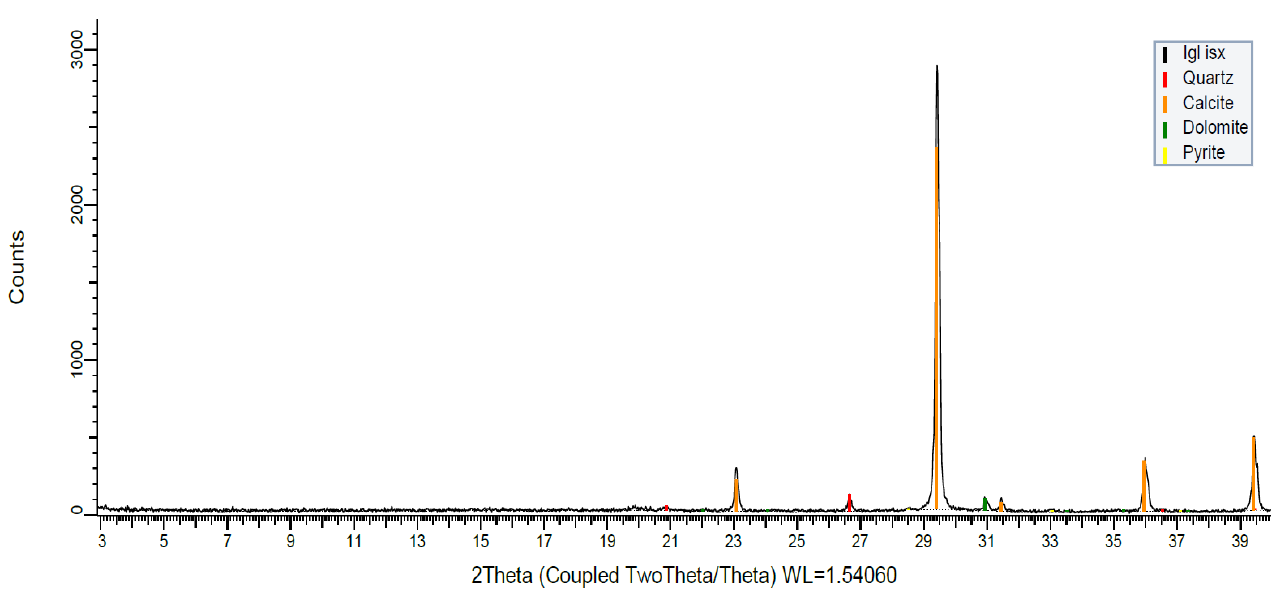
Figure 6. Diffractogram of the original core sample. Based on the XRD results, we can see that the samples are represented by carbonates without clay minerals, which indicates that there is no risk of rock swelling during steam injection. Initial oil saturation was estimated by two methods: extraction and thermogravimetric analysis (TGA) [31]. The results are shown in Figure 7.